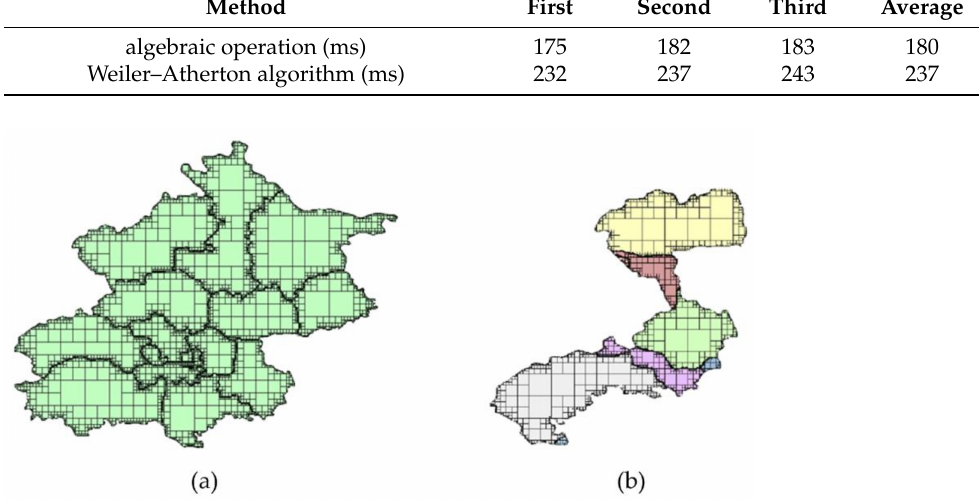
Figure 19. Experiments of overlay: layer ( a ) is a layer with multiple area objects. We moved ( a ) along the x -axis and formed a new layer, which was overlaid with the old layer ( a ). Layer ( b ) is the result of the overlay. Table 3. Comparing study of the two algorithms for a layer with multiple area